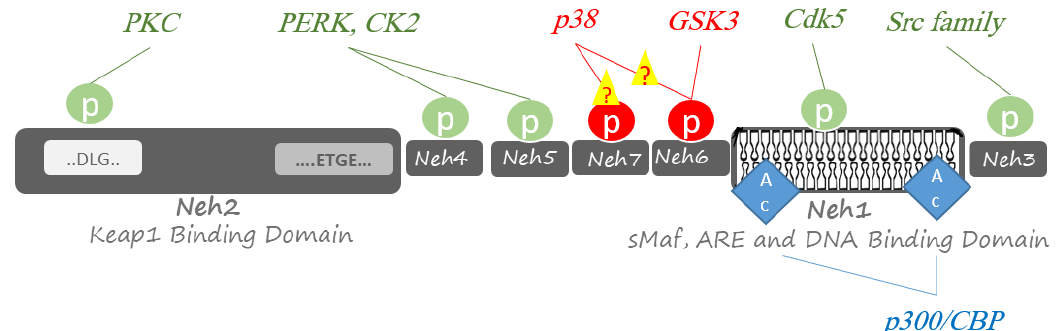
Figure 2. Post-translational phosphorylation and acetylation of Nrf2. Phosphorylation of Nrf2 is performed at Ser/Thr residues by multiple protein kinases to activate Nrf2-related responses to oxidative stresses (green circles) or proteasomal degradation by a Cullin1/Rbx1 complex (red circles). Acetylation of Nrf2 at several Lys residues by transcriptional co- activators p300 and CREB-binding protein (CBP); p300/CBP has a boosting effect on Nrf2 for binding DNA (blue dia- mond).